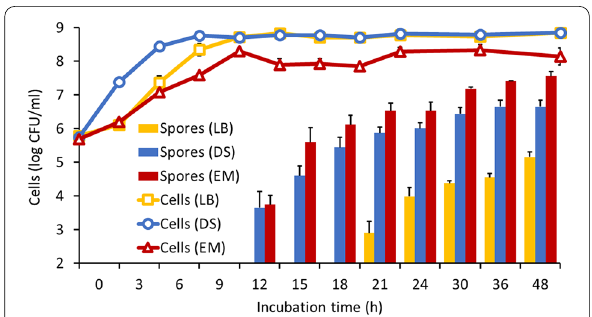
Fig. 3 Growth and sporulation kinetics in EM and commercial media. The line graph showing the change in the total number of cells. Error bars represent standard deviation obtained through triplicate experiments. Error bars smaller than the mark are not